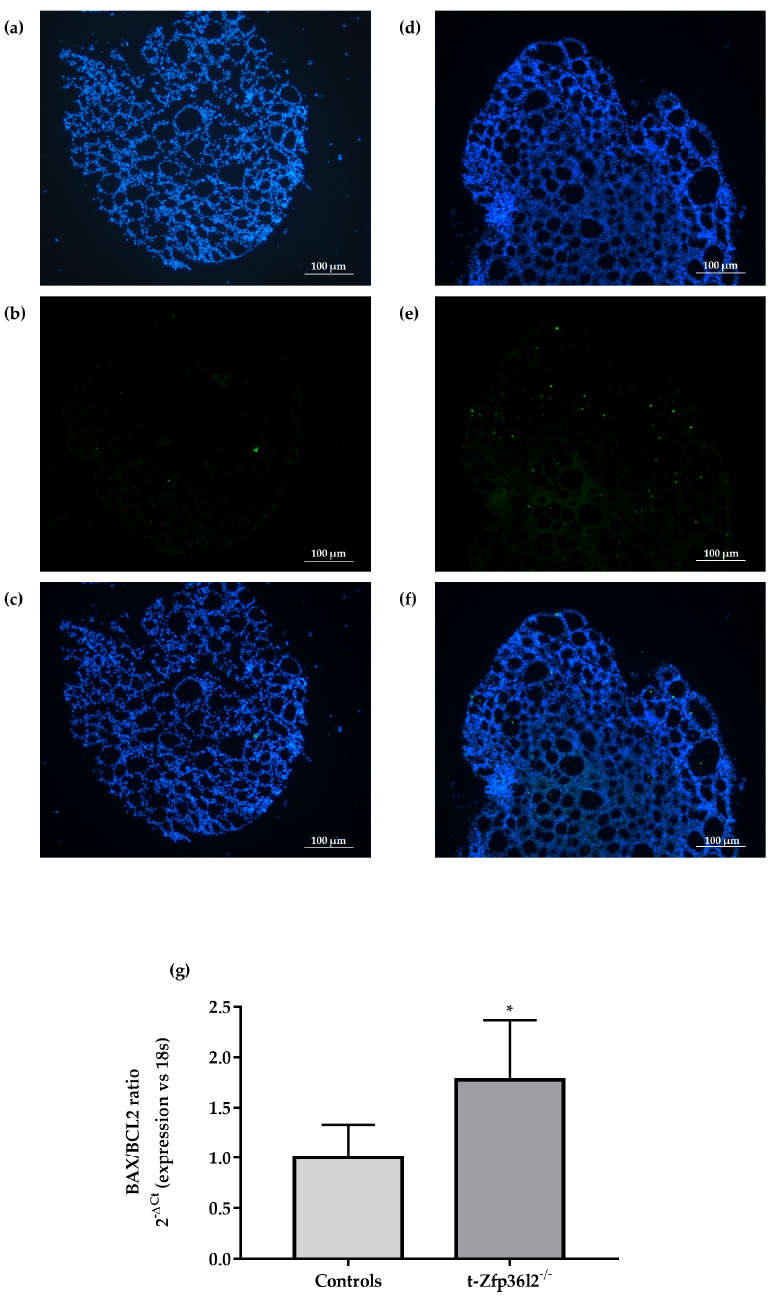
Figure 3. Analysis of apoptosis in control ( n = 3) and t − Zfp36l2 -/- mice ( n = 3). 10X magnification images of DAPI staining of thyroid samples from controls ( a ) and t − Zfp36l2 -/- mice ( d ); nuclei positive Tunel staining in controls ( b ) and t − Zfp36l2 -/- mice ( e ). The merge of the previous images is shown in ( c ) for controls and ( f ) for t − Zfp36l2 -/- mice. RTqPCR in extracts from thyroid samples was conducted to determine the levels of Bax and Bcl2 mRNAs. The Bax / Bcl2 transcript ratios in control ( n = 3) and t − Zfp36l2 -/- mice ( n = 3) ( g ). RTqPCR Bax / Bcl2 ratio between mean and standard deviation of Bax and Bcl2 ∆ Ct values (FC values of each gene vs. FC of 18SrRNA), in KO ( n = 3) and control mice ( n = 3); * p < 0.05.